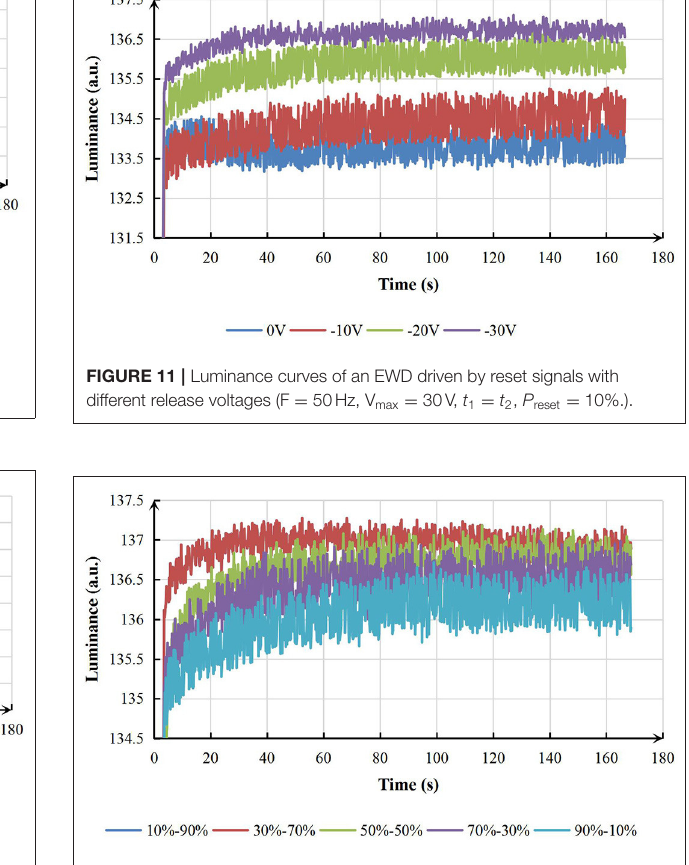
FIGURE 12 | The curve of brightness-voltage of an EWD with the different ratio of t 1 / t 2 (F = 50Hz, V max = 30V, V Release = − 30V, P reset =